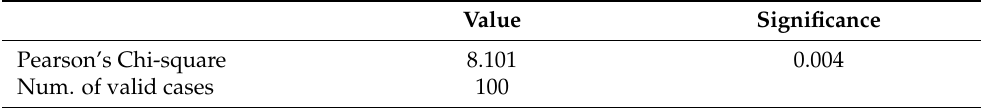
Table 7. Chi-square